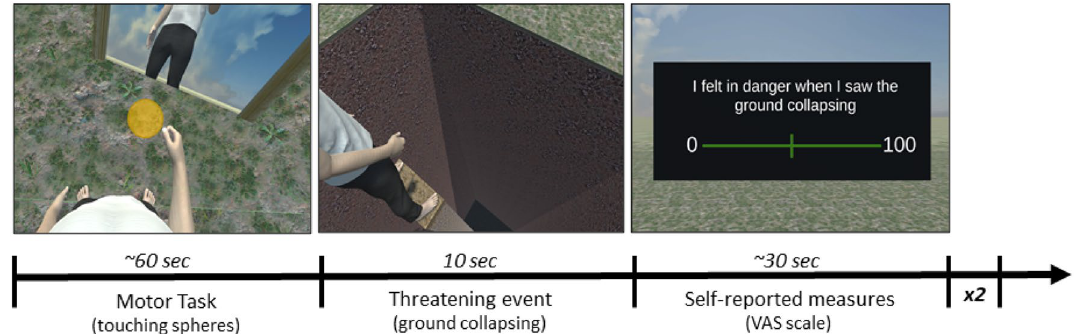
Figure 3. Study 1 Timeline, which included the motor task (touching the virtual spheres), the threatening event (ground collapsing), Self-reported